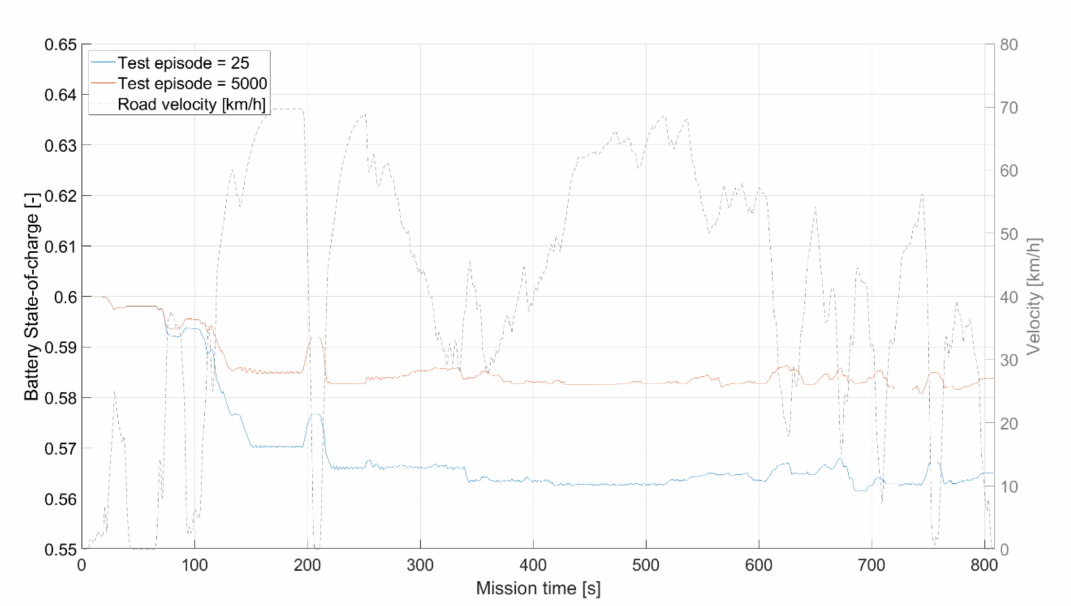
Figure 14. Battery SoC over CLUST1 evaluated throughout the first saved and last testing